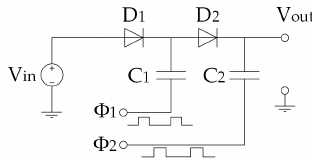
Figure 44. A Dickson charge pump.